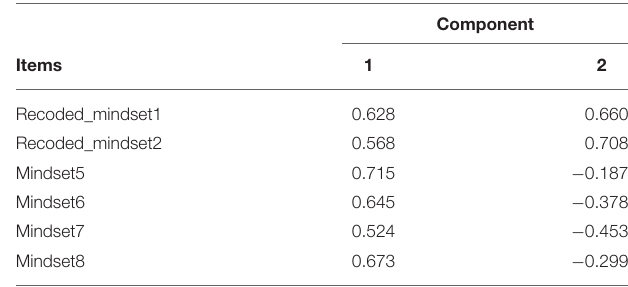
TABLE 2B | Component matrix with items three and four of the mindset scale TABLE 2A | Component matrix with all mindset scale items included. excluded. Component